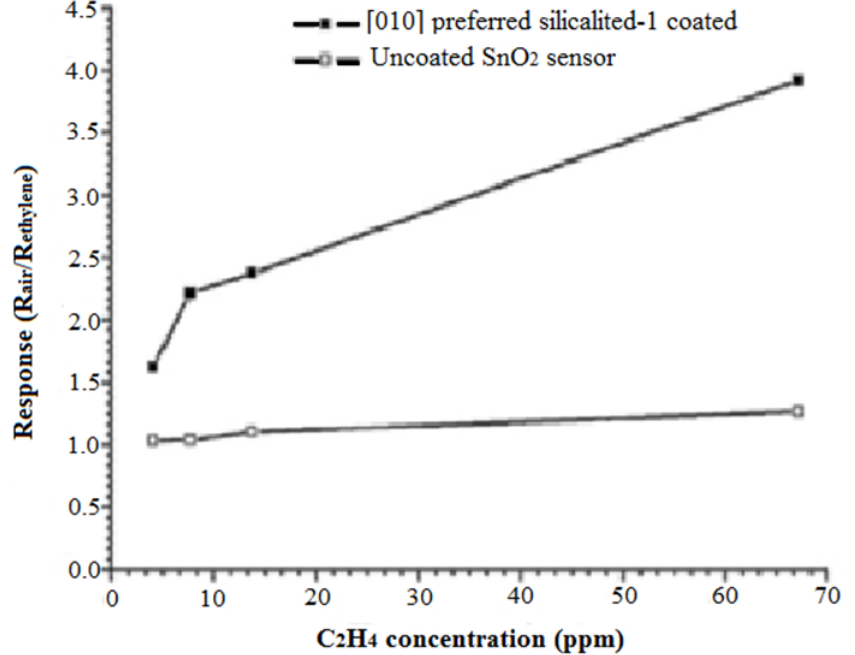
Figure 5. The response of preferentially coated [010] silicalite-1 layer and uncoated SnO thin film sensors towards ethylene, 350 °C (adapted from Reference